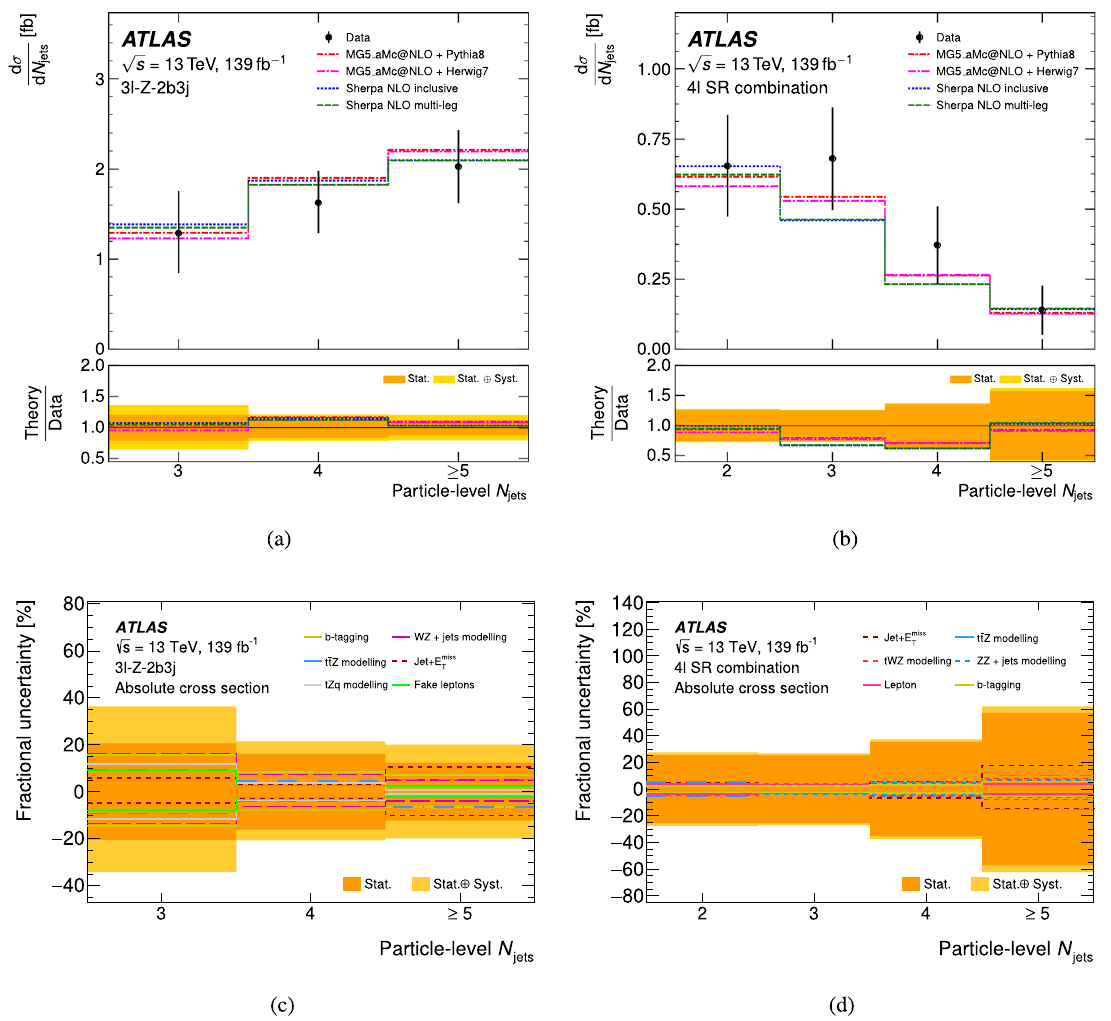
Fig. 12 Absolute differential t ¯ tZ cross section measured at particle level as a function of N jets with p T > 25 GeV for a the trilepton and b the tetralepton event selection. c , d Show the relative contributions from different categories of systematic uncertainties per